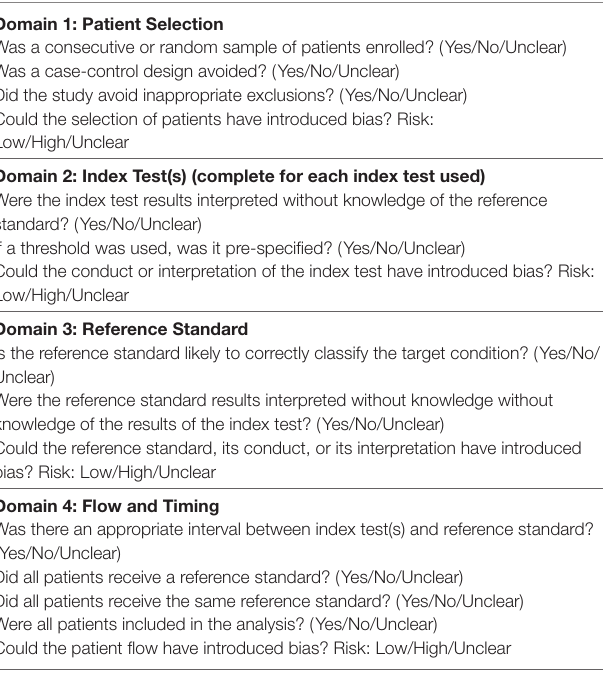
taBLe 1 | Quality Assessment of Diagnostic Accuracy Studies-2 checklist [adapted from Whiting et al.